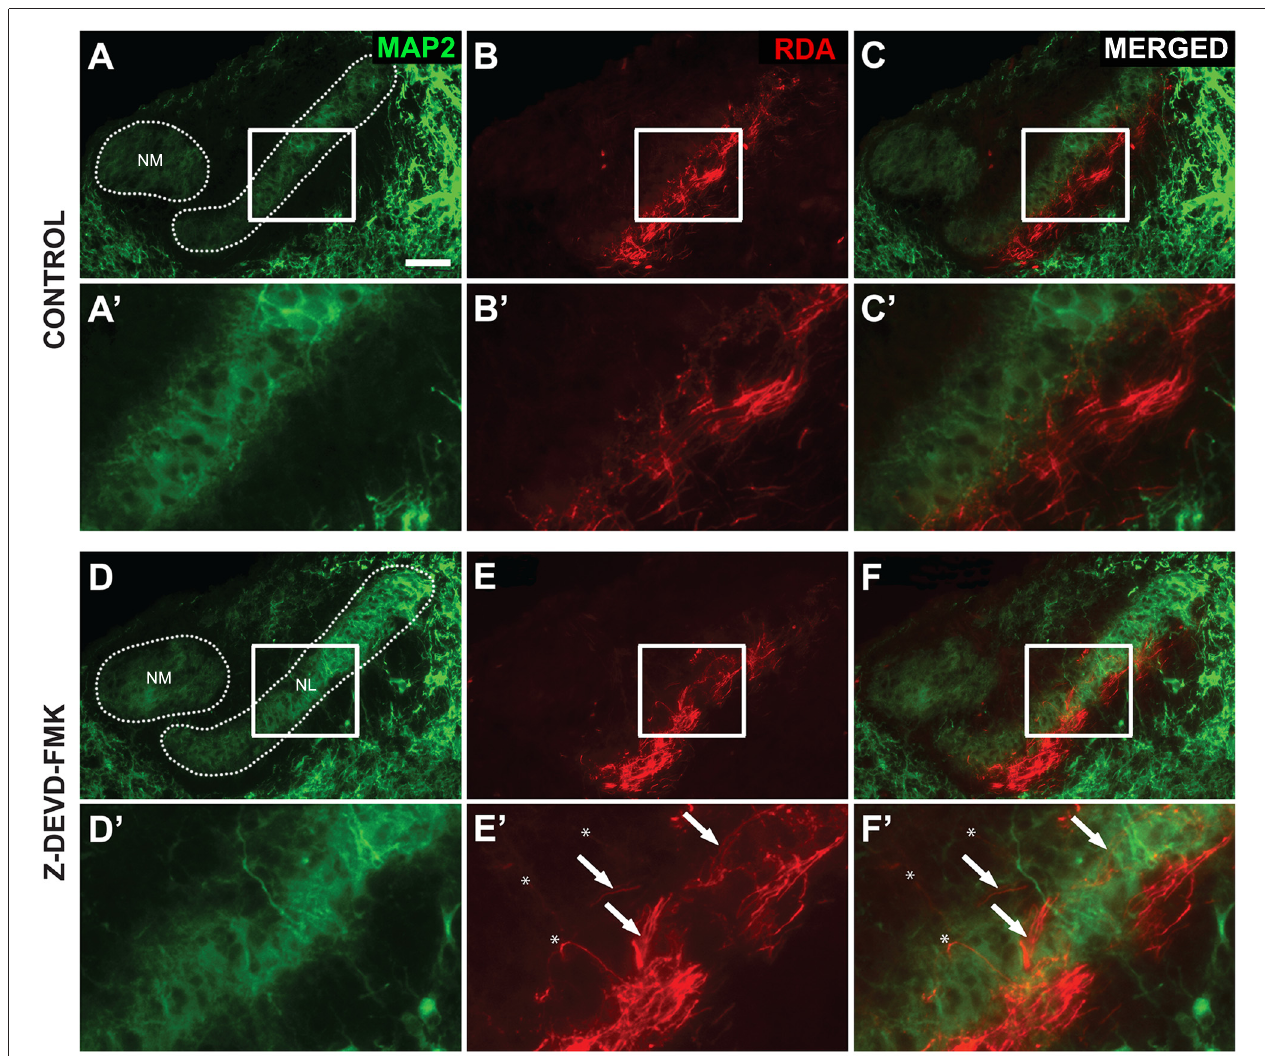
FIGURE 5 | Axon tract targeting is impaired in Z-DEVD-FMK injected embryos. (A) Microtubule-associated protein 2 (MAP2) immunolabel shows the extent of NM and NL in a control embryo. (A (cid:48) ) Higher power shows inset. (B,B (cid:48) ) The same section showing rhodamine dextran amine (RDA) labeling from the midline in revealing axon terminations in NL. (C,C (cid:48) ) Merged images demonstrated that these terminations are appropriately limited to the ventral portion of NL. (D,D (cid:48) ) MAP2 immunolabel in a Z-DEVD-FMK injected embryo. (E,E (cid:48) ) RDA labeling from midline in the section shown in (D) . Axon arbors deviate from the normally confined ventral region. Axon tracts (white arrows) and individually resolvable axons (asterisks) were observed. (F,F (cid:48) ) Merged image shows the extent of mistargeting in the NL region. Scale bar in (A) = 100 µ m, applies to (A–F) .